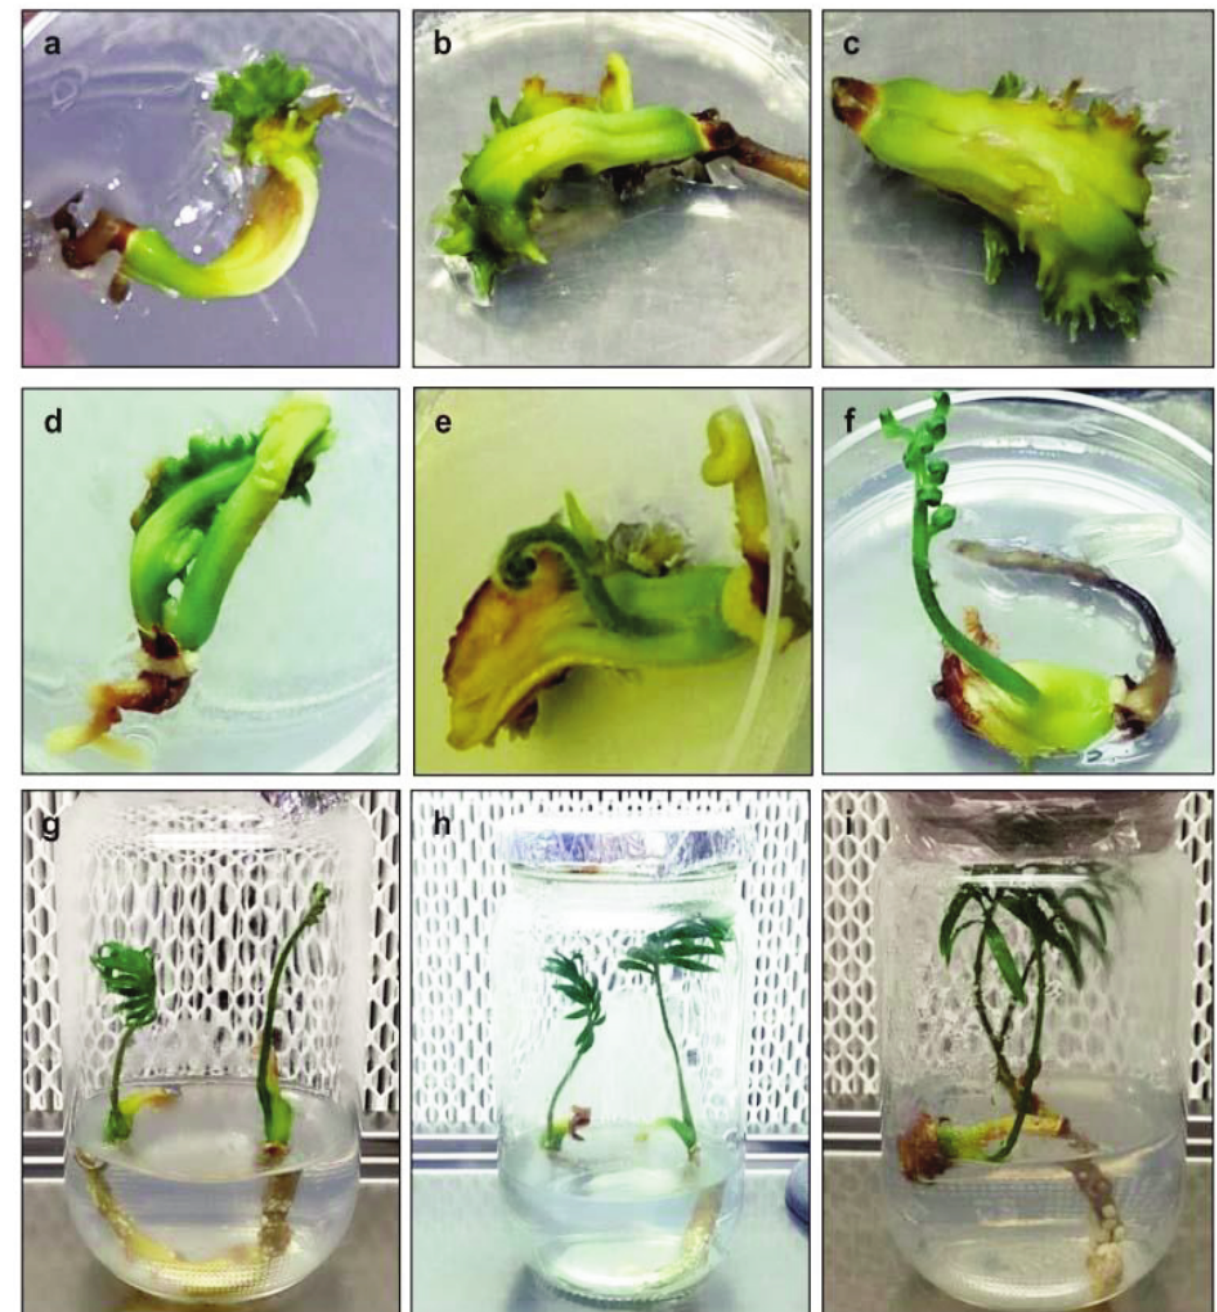
Fig. 3 ­ Effect of phytohormones on zygotic embryos development. (a) shoot induction in SH basal medium, (b, c) shoot regeneration in SH medium supplemented with 0.5 mg of BAP and 0.5 mg of 2iP respectively, (d, e, f) shoot elongation SH, SH+BAP and SH+2iP Prespectively, (g, h, i) rooted plants after 3 months of culture in SH, SH+BAP and SH+2iP,